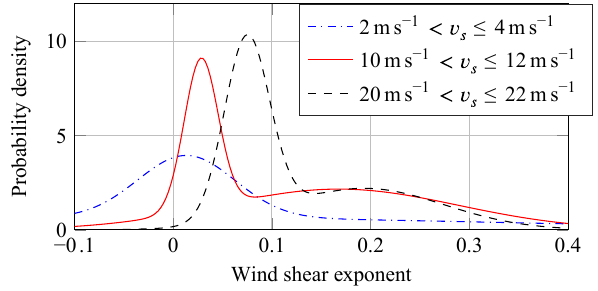
Figure 8. Turbulence intensity (mean value and 90th percentile ( Q 0 . 9 )) for different wind speeds compared to the